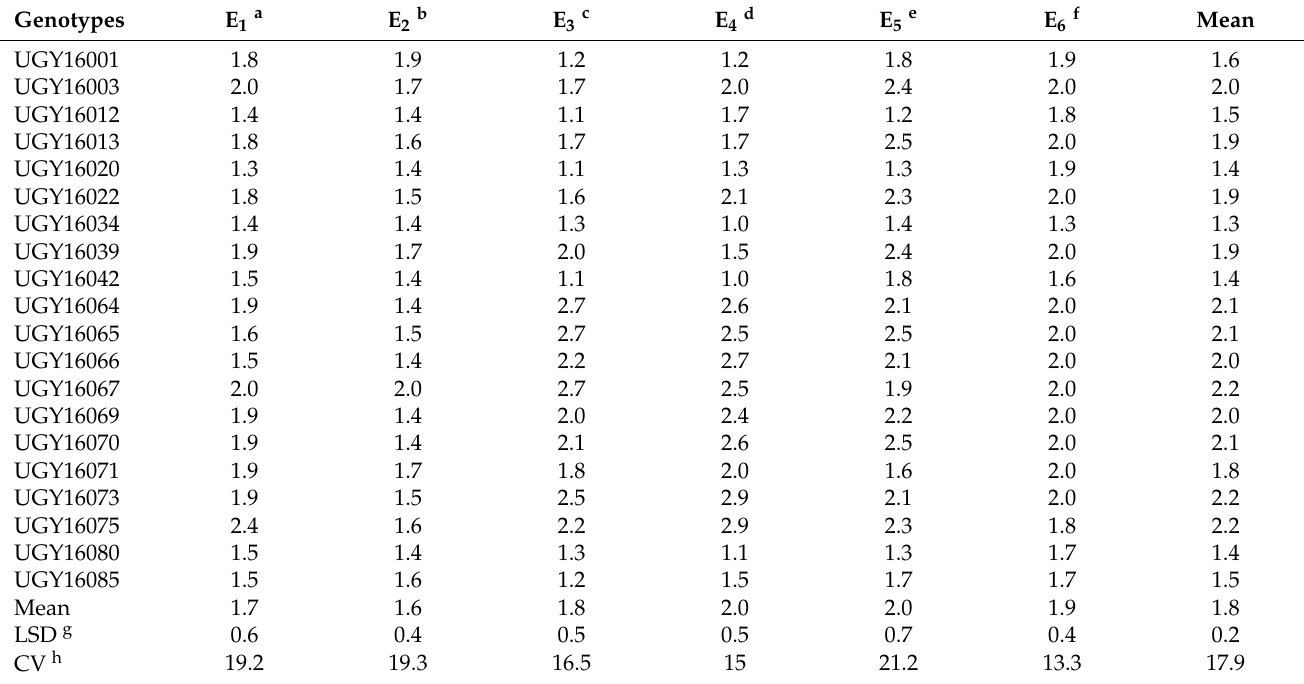
Table 6. Mean yam mosaic virus severities for 20 yam genotypes assessed in six test environments within Uganda.